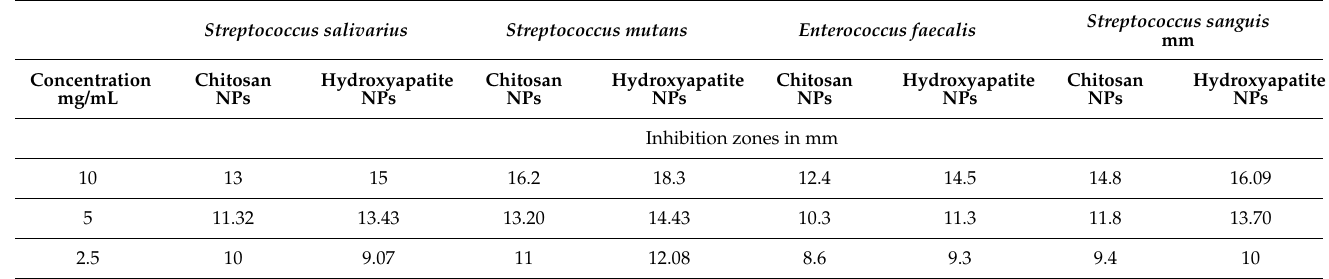
NPs = nanoparticles.